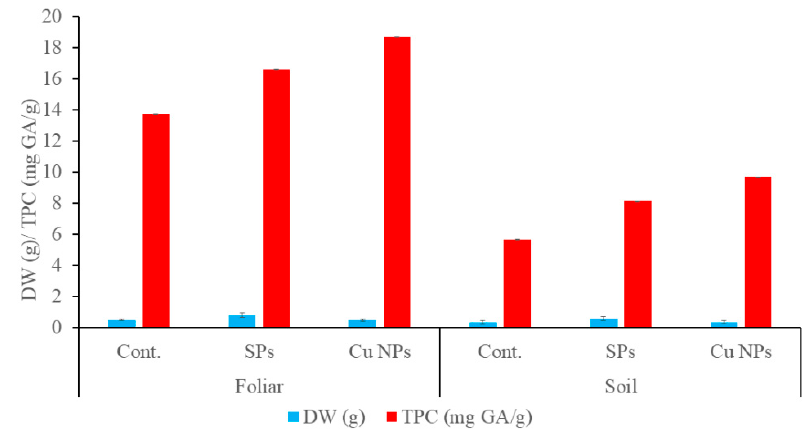
Figure 6. Dry weight and total phenolic content of wheat seedlings treated by 0.06 mg/L of SPs and Cu NPs after 28 days from foliar and soil applications.